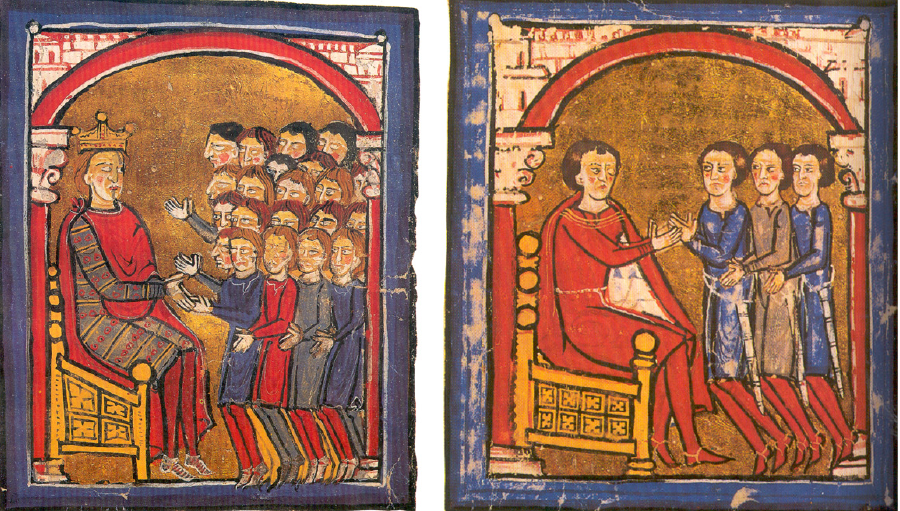
Figure 6. Liber Feudorum Ceritaniae , Canc. Reg. 4, Barcelona, Arxiu de la Corona d’Arag ó ©. Fols. 62r and unknown. Alphonse as king of Aragon and as count of Barcelona. Published by Catalunya medieval , pp. 203 and